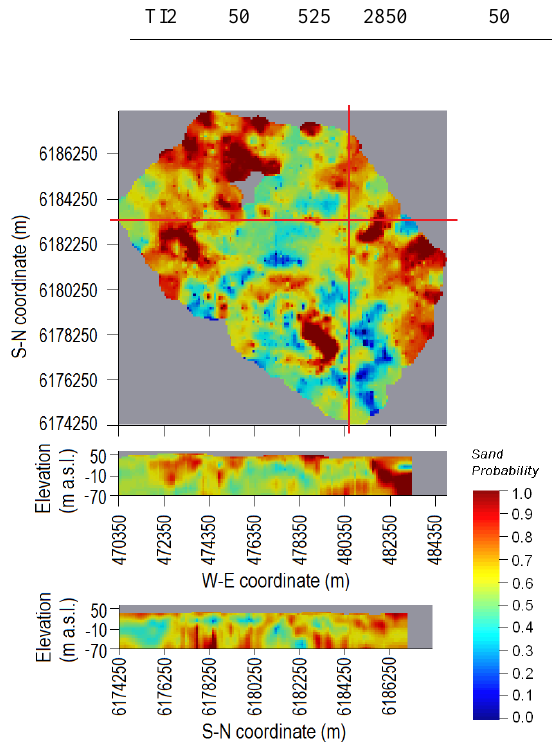
Figure 5: Cross sections of the 3-D map showing the probability of Quaternary sand converted 2 Figure 5. Cross sections of the 3-D map showing the probability from SkyTEM data. The horizontal plane is taken at 10 m a.s.l.. 3 of Quaternary sand converted from SkyTEM data. The horizontal plane is taken at 10ma.s.l.